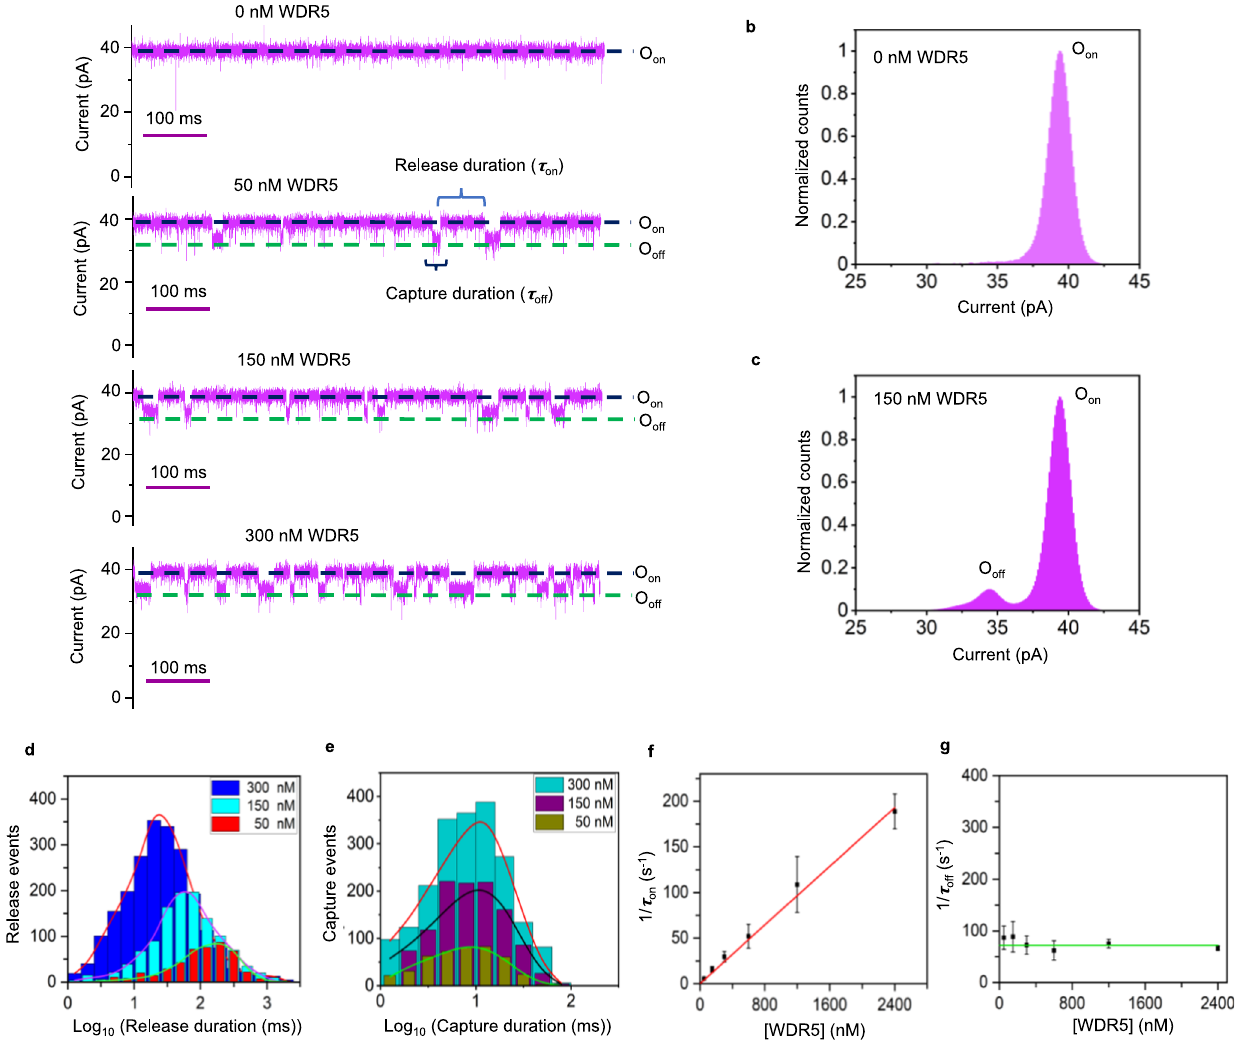
Fig. 3 | Single-molecule sensing of WDR5. a Representative single-channel elec- trical traces (in magenta) of Mb4-tFhuA in the presence of 0, 50, 150, and 300nM WDR5. O on and O off are the WDR5-released and WDR5-captured substates, respectively. τ on and τ off are the durations of the WDR5-released and WDR5- captured events, respectively. These single-channel electrical signatures were replicated in n =3 independent experiments. The other conditions were the same as those in Fig. 2. b A current histogram (in magenta) of the O on substate of Mb4- tFhuA. The current (mean±s.e.m.) corresponding to the O on substate was 39.5±0.1pA. c A current histogram (in magenta) of the O on and O off substates of Mb4-tFhuA at 50nM WDR5. The current (mean±s.e.m.) corresponding to the O off substate was 34.5±0.1pA. d Histograms of the WDR5-released durations ( τ on ) at